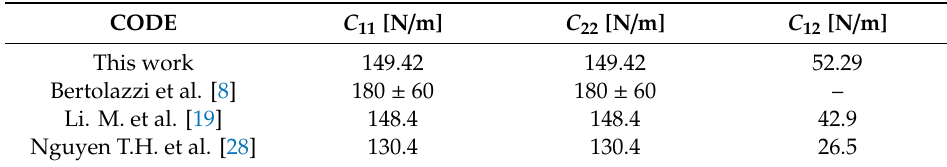
Table 1. The material properites of MoS 2.